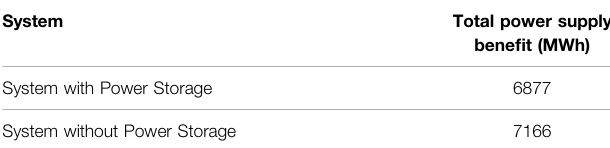
TABLE 1 | Power Supply Bene fi t of the two